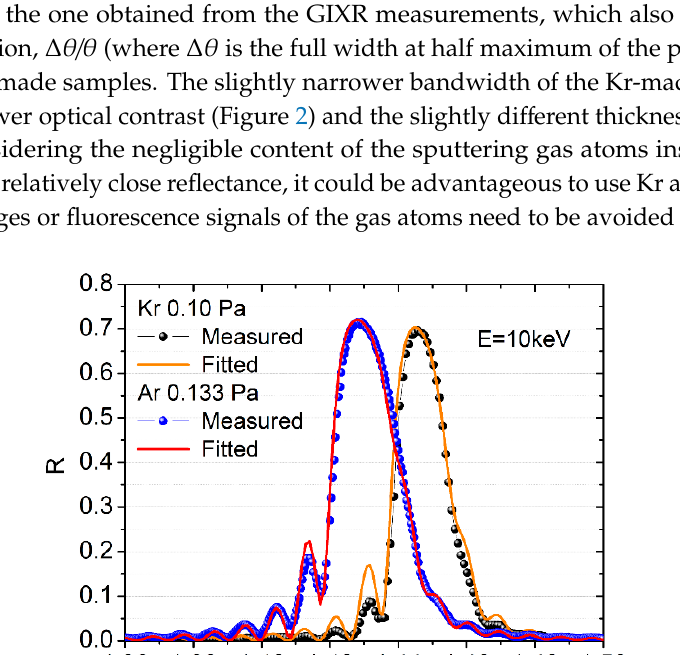
Figure 6. Electron energy loss spectroscopy (EELS) results of the depth profiles of the elemental concentration in Ar ( a ) and Kr ( b ) sputtered samples.